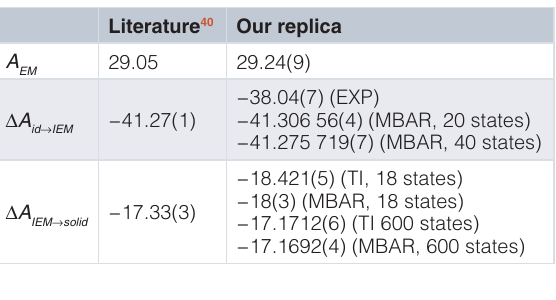
Table 4. Simulation data for solutions of acetylsalicylic acid in water in different concentrations.